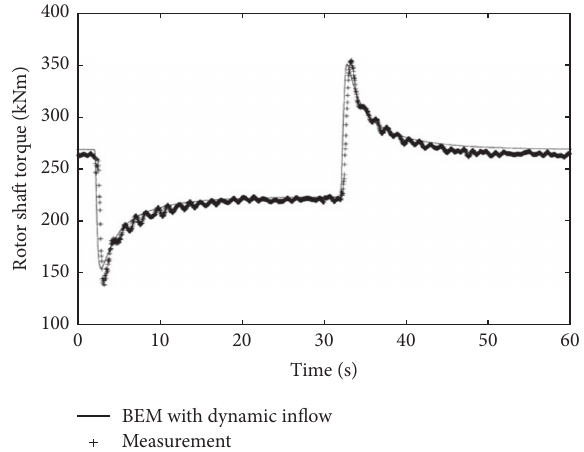
Figure6:Comparisonbetweenmeasuredandcomputedtimeseries of the rotor shaft torque for the Tjaereborg machine during a step input of the pitch for a wind speed of 8.7 m/s